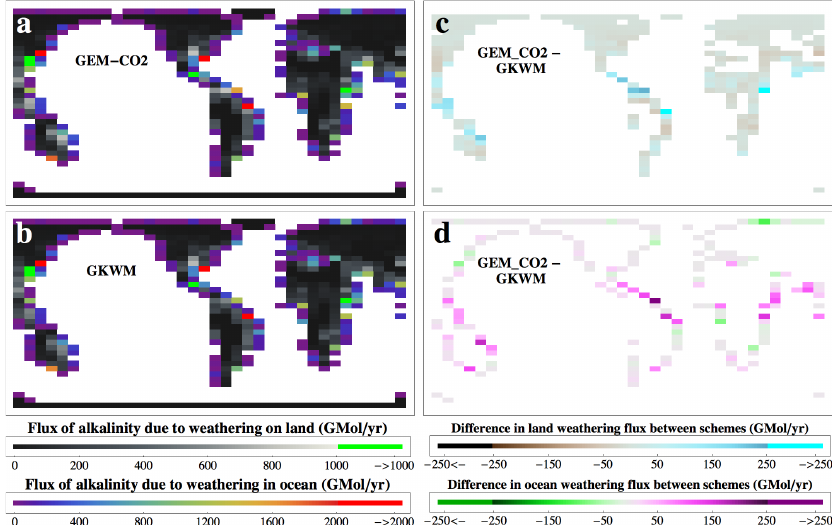
Fig. 19. Distribution of weathering flux on land (grey scale), and once routed to the coast, in the ocean (colour scale) for a post-spin-up, pre-industrial climate, for each of the 2-D weathering schemes, GEM-CO2 (a) and GKWM (b) . The GEM-CO2 lithological dataset is used. There is a small difference between the schemes, as shown in (c) (land weathering rate) and (d) (coastal input rate).